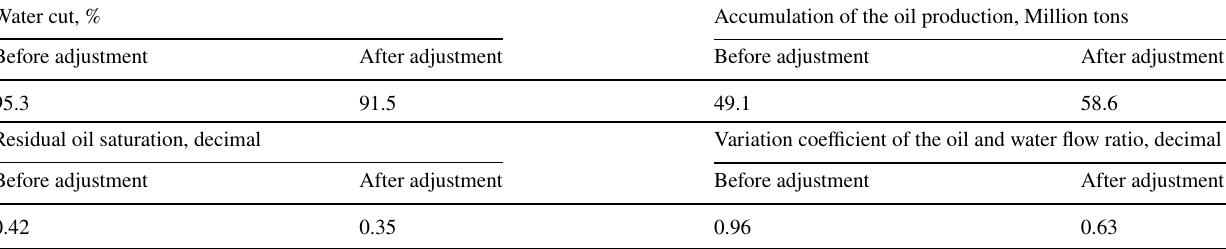
Table 3 Comparison of parameters before and after adjustment of the Nm3-4-1 layer streamline field Water cut,